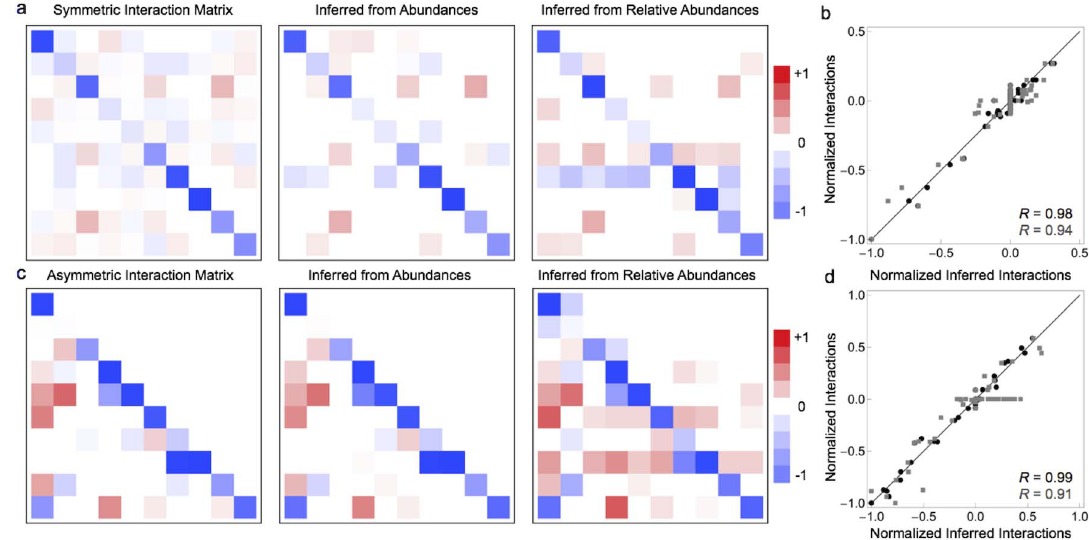
Figure 3. Example fits of interaction parameters using sparse linear regression. a) A symmetric interaction matrix (left), the corresponding matrix inferred from absolute abundance data (middle), and the corresponding matrix inferred from relative abundance data (right). b) There is good aggreement between the true and inferred interactions, from both absolute (black) and relative (gray) abundances, for the symmetric interaction matrix. c) An asymmetric interaction matrix (left), the corresponding matrix inferred from absolute abundance data (middle), and the corresponding matrix inferred from relative abundance data (right). d) There is good aggreement between the true and inferred interactions, from both absolute (black) and relative (gray) abundances, for the asymmetric interaction matrix. The prediction error threshold was set to 5% in for all fits.